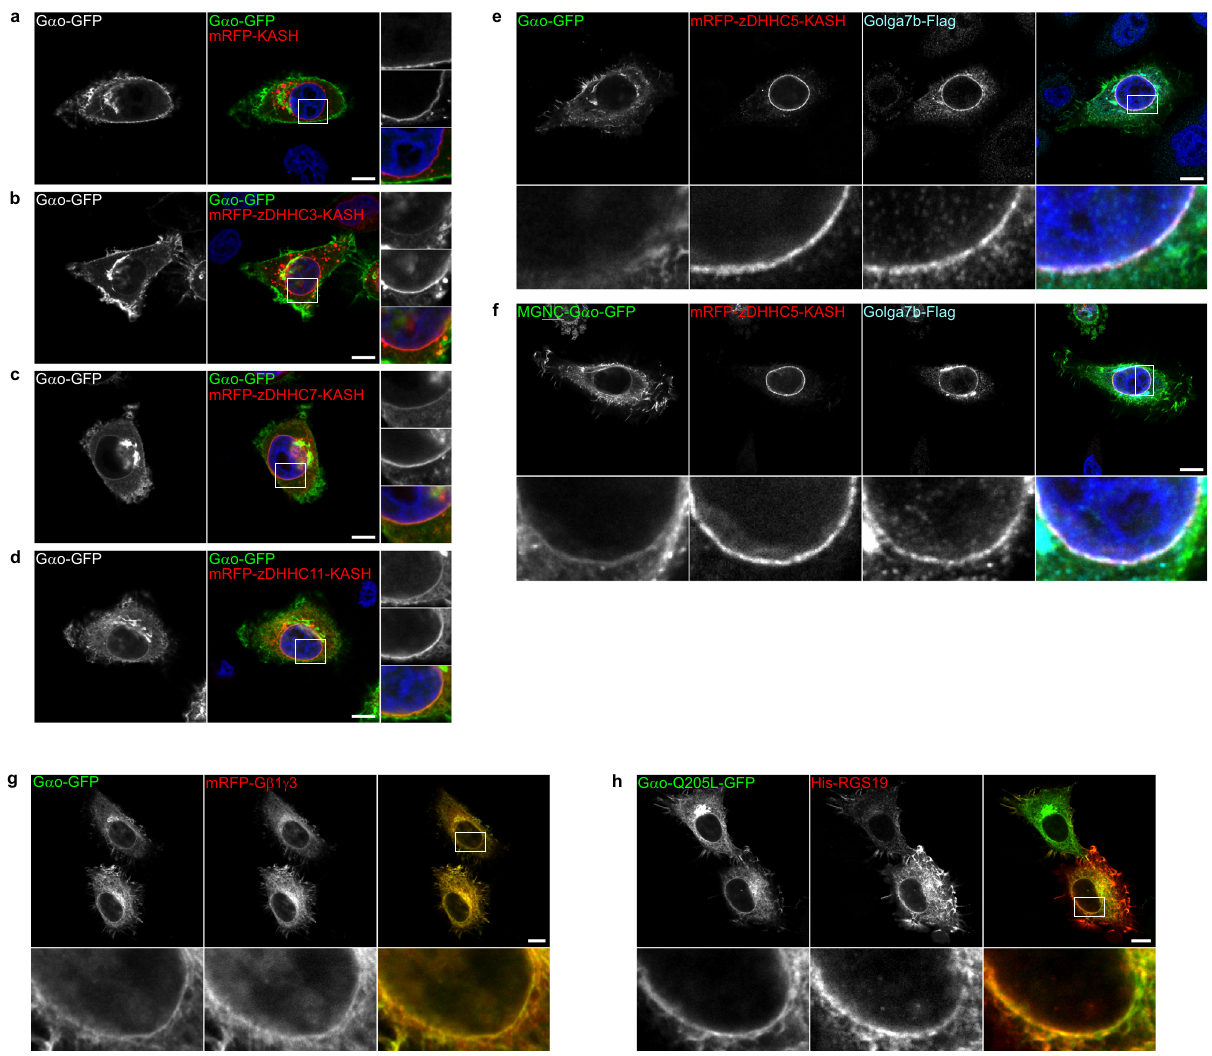
Fig. 9 Targeting of full-length G α o to the ONM. a – d The SwissKASH assay for full-length G α o (G α o-GFP) using the control mRFP-KASH ( a ), zDHHC3 ( b ), zDHHC7 ( c ) and zDHHC11 ( d ) in HeLa cells. Nuclei stained in blue with DAPI. Color-channels are listed vertically top-to-bottom and selected areas are magni fi ed to the right with the channels displayed also vertically in the same order. Note that the ONM accumulation of G α o-GFP is induced by all zDHHCs but not the control mRFP-KASH. e , f The full-length G α o-GFP ( e ) and its MGNC mutant (MGNC-G α o-GFP; f ) were tested in the SwissKASH system using mRFP-zDHHC5-KASH and Golga7b-Flag. Cells were immunostained against Flag-tag. Marked regions are magni fi ed at the bottom panels. Underlined letters indicate residues substituted in the Nt 7 region of G α o. Note that only MGNC-G α o-GFP ( f ) and Golga7b ( e , f ) accumulate at the ONM. g , h The SwissKASH assay applied to G α o-GFP ( g ) and its GTPase-inactive mutant Q205L ( h ) together with mRFP-G β 1 γ 3 ( g ) or His 6 -tagged RGS19 (His-RS19; h ), and using BFP- zDHHC11-KASH (not displayed). Cells were immunostained against the His 6 -tag ( h ). Selected areas are magni fi ed at the bottom panels. a – h Scale bars, 10 µ